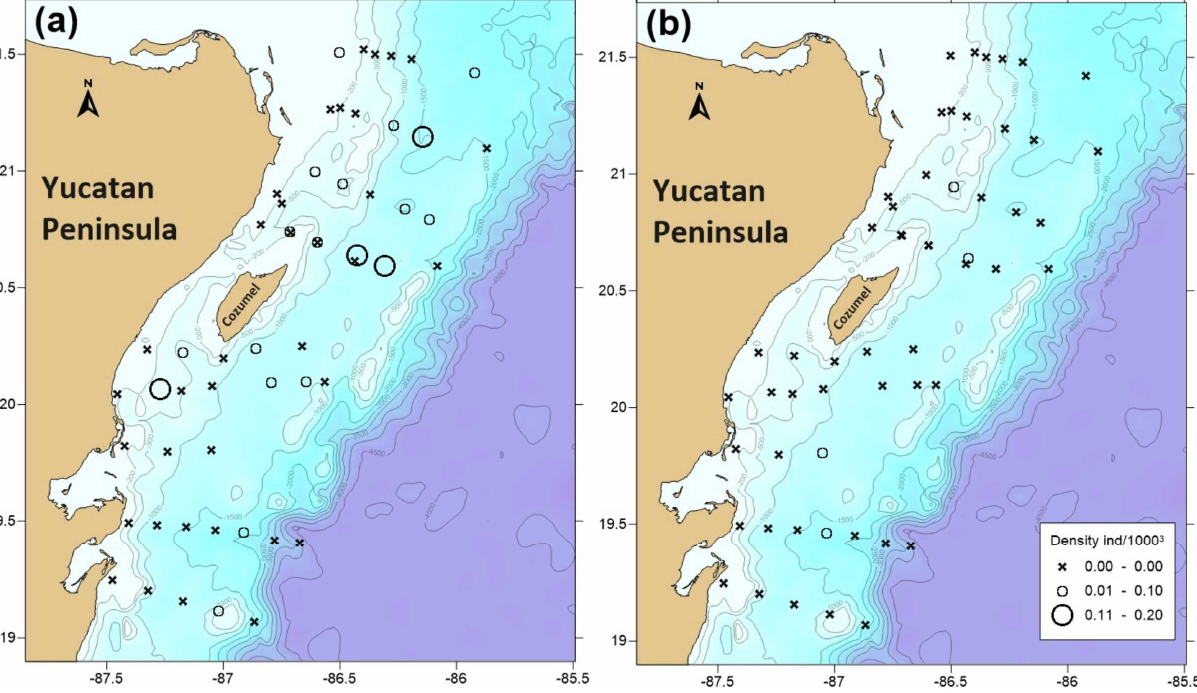
14 groups: the mid- and late-stage phyllosomata of P. argus , P. guttatus , P. gundlachi , J.